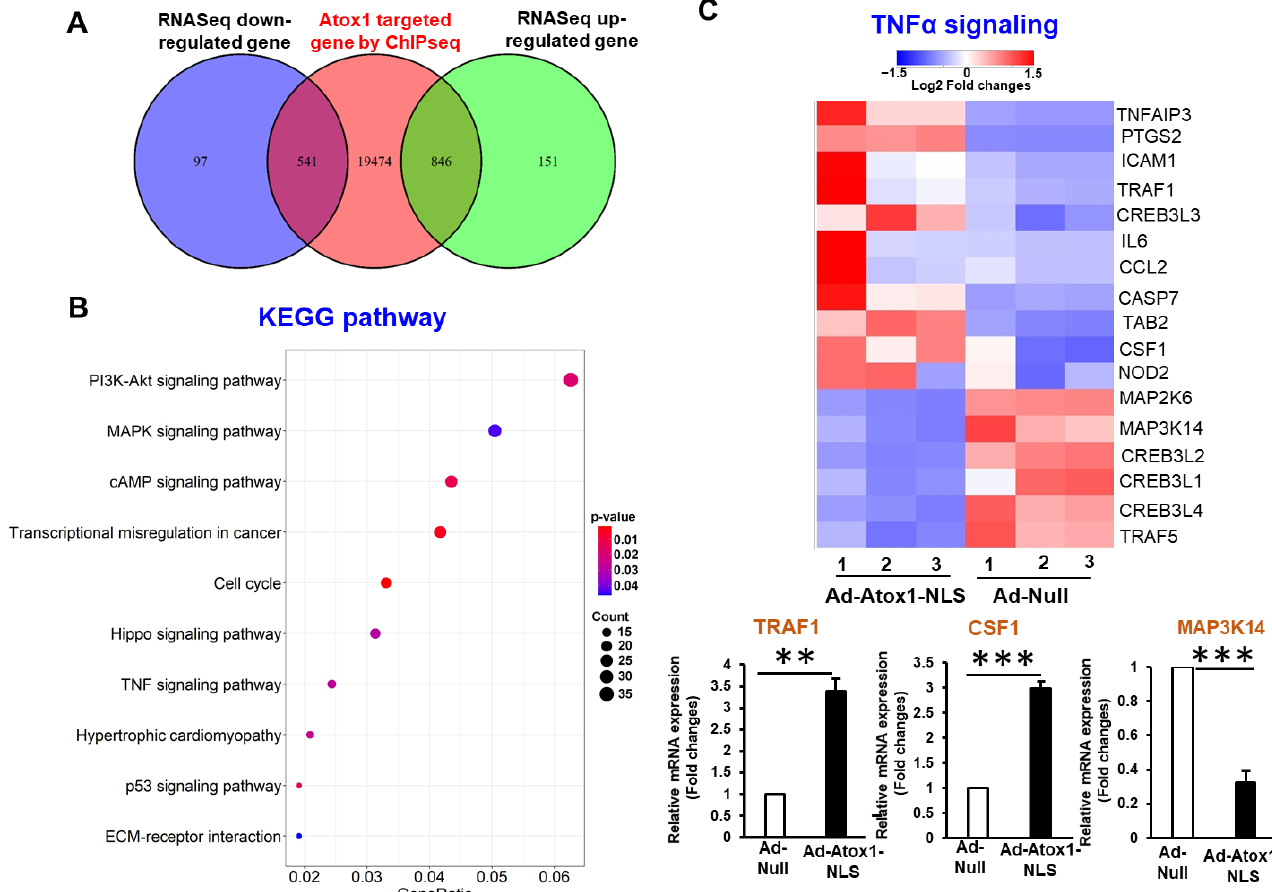
Figure 4. Analysis of nuclear Atox1-regulated genes. ( A ). Venn diagrams showing the overlap between differentially expressed genes (DEGs) identified by RNA-Seq and Atox1-bound genes identified by ChIP-Seq. ( B ). KEGG pathway enrichment analysis based on those 1387 overlapped DEGs in A. The top 10 enriched pathways ranked by the number of DEGs in the pathways are shown here. ( C ). Top: Heatmap showing the expression levels of DEGs belonging to the TNF signaling pathway in RNA-Seq. Color scale depicts range of log2 fold changes in gene expression. Bottom: Three selected DEGs in this pathway was validated by quantitative RT-PCR (n = 3) *** p < 0.001, ** p < 0.01.